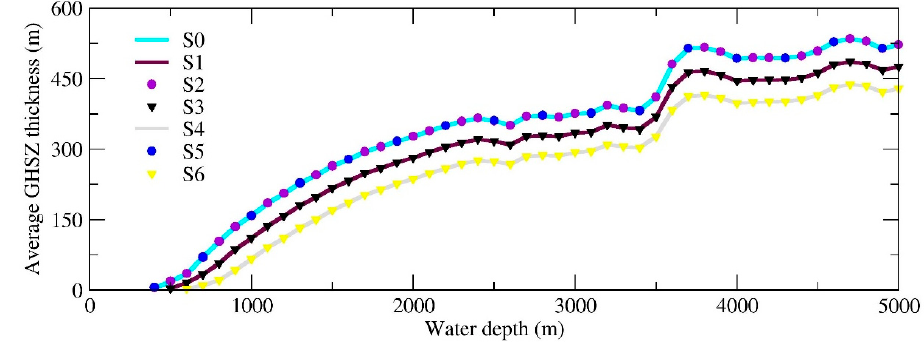
Figure 5. Average thickness of GHSZ. In every scenario, the thickness increases from the shelf-upper slope to the lower slope.